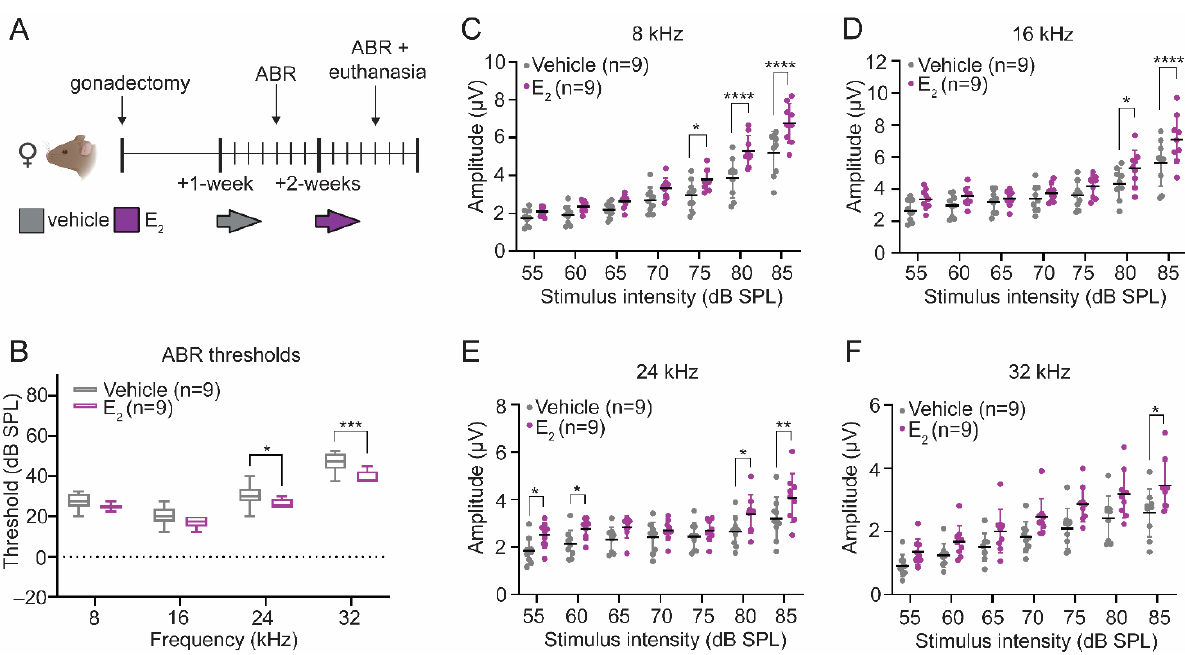
Figure 1. E 2 -replacement in gonadectomized female mice modulates auditory brainstem response (ABR) thresholds and wave-1 amplitudes. ( A ) Schematic of the within-animal experimental design. Female mice were gonadectomized at 8-weeks of age. Mice received 3 daily subcutaneous injections of vehicle 1-week post-gonadectomy and 3 daily subcutaneous injections of E 2 (300 µg/kg) 2-weeks post-gonadectomy. ( B ) Following E 2 -replacement, ABR thresholds improved at 24 kHz ( p = 0.0416) and 32 kHz ( p = 0.0003). ( C – F ) E 2 -replacement increases suprathreshold ABR wave-1 amplitudes at ( C ) 8